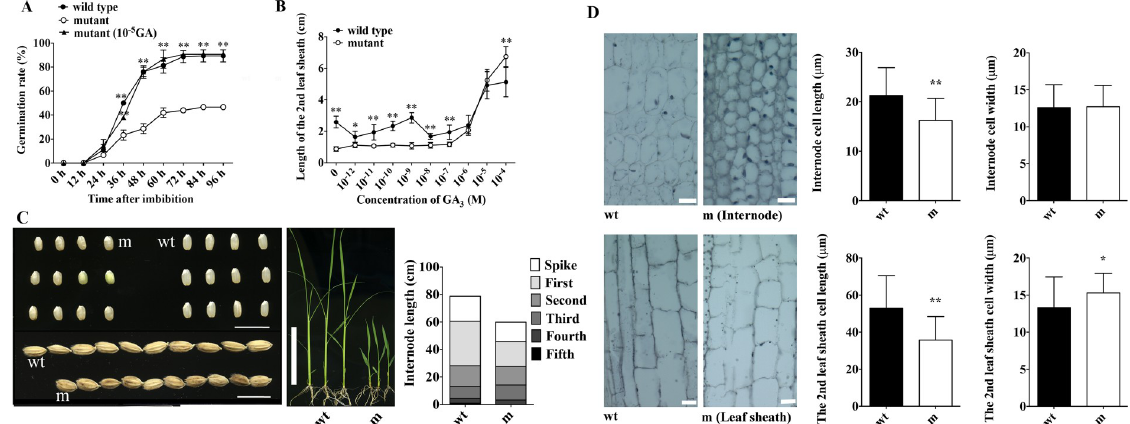
Fig 1. Phenotypic characterization of the mutant. (A) Comparison of seed germination among wild-type, mutant, and mutant treated with 10 − 5 M GA 3 . (B) Elongation of the second leaf sheath of mutant and wild-type rice in responding to gradient concentration of GAs. (C) Morphological phenotypes of mutant in comparison with wild type. Left and middle panels show the seed size and seedlings, respectively; and the right panel shows the comparison of different internodes. Data are means from n � 25 plants. Scale bars = 1 cm. (D) Microscope images (left panels) and quantitative analysis (right panels) of the second internode (upside panels) and leaf sheath (bottom panels) cell length. “m” stands for the mutant, and “wt” stands for the wild type. Data are means ± SE from at least 4 plant sections with at least 6 cells in each section. Significant difference was determined by Student’s t-test ( � p < 0.05, �� p < 0.01). Scale bars = 10 μ